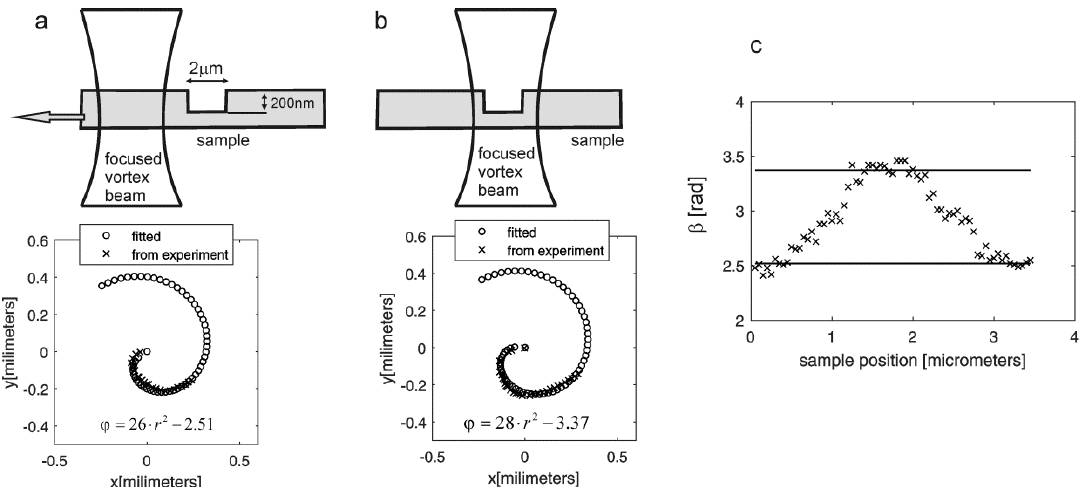
Figure 11. ( a , b ) Schematic presentation of the experiment, sample with the phase step was shifted through the focused vortex beam causing rotation of the spiral profile in the case where the step was inside the beam; ( c ) Values of the parameter β correspond well with the expected phase shift. The lower solid line indicates ϕ 0 level (2.51 rad) and the upper solid line indicates 3.37 rad.